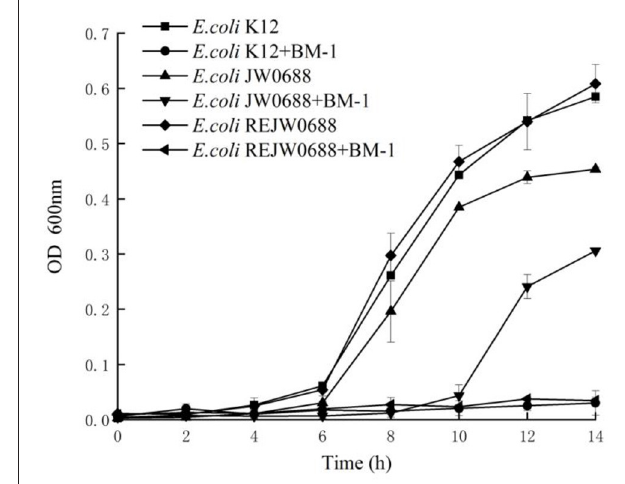
FIGURE 2 | Effect of plantaricin BM-1 on the growth of wild type E. coli K12, mutant E. coli JW0688, and E. coli ReJW0688. (cid:4) , N and (cid:7) represent the OD 600 values of wild type E. coli K12, mutant E. coli JW0688, and E. coli ReJW0688 in the absence of bacteriocin, respectively. • , N and ◭